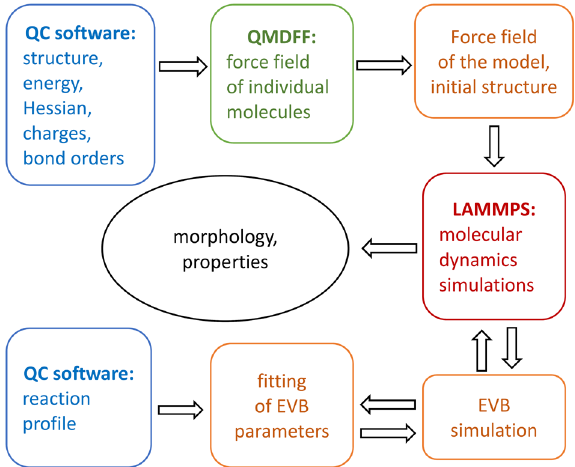
Fig. 1 A fl owchart of the LAMMPS implementation of the QMDFF force fi eld. Blue units correspond to quantum chemistry (QC) software (Gaussian 16 36 was used) and green to the QMDFF tool. Our contribution is shown with red (modi fi ed version of LAMMPS) and orange (python tools)